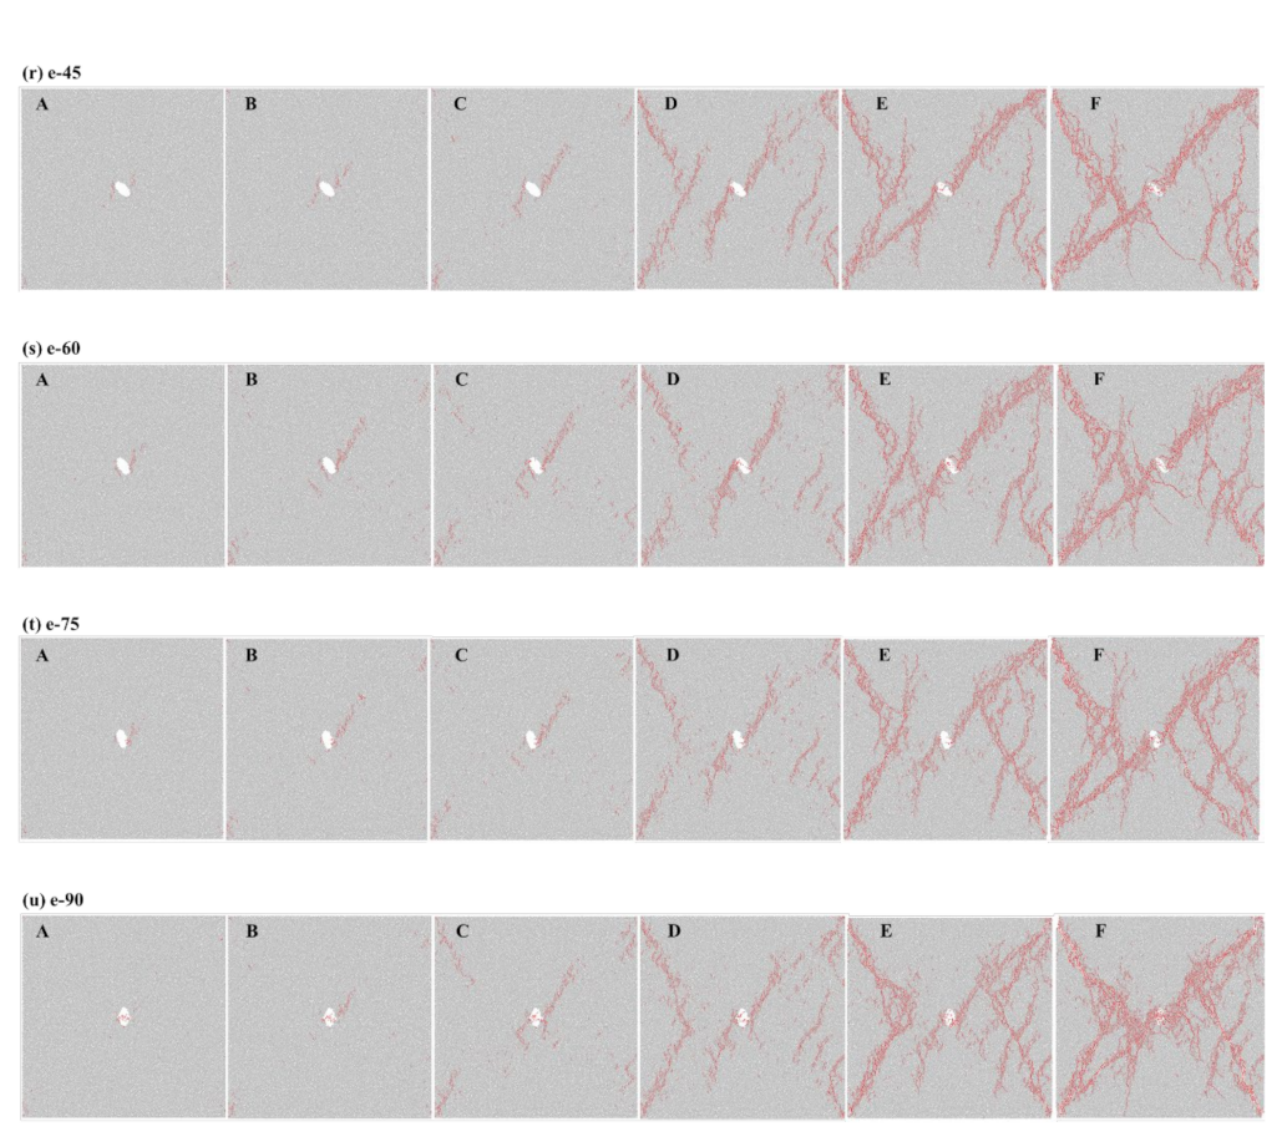
Figure 8. Cracking developments of pre-holed granite specimens under coupled biaxial loading and unloading conditions. ( a ) a-0; ( b ) a-15; ( c ) a-30; ( d ) a-45; ( e ) a-60; ( f ) a-75; ( g ) a-90; ( h ) s-0/90; ( i ) s-15; ( j ) s-30; ( k ) s-45; ( l ) s-60; ( m ) s-75; ( n ) c-0; ( o ) e-0; ( p ) e-15; ( q ) e-30; ( r ) e-45; ( s ) e-60; ( t ) e-75; ( u )